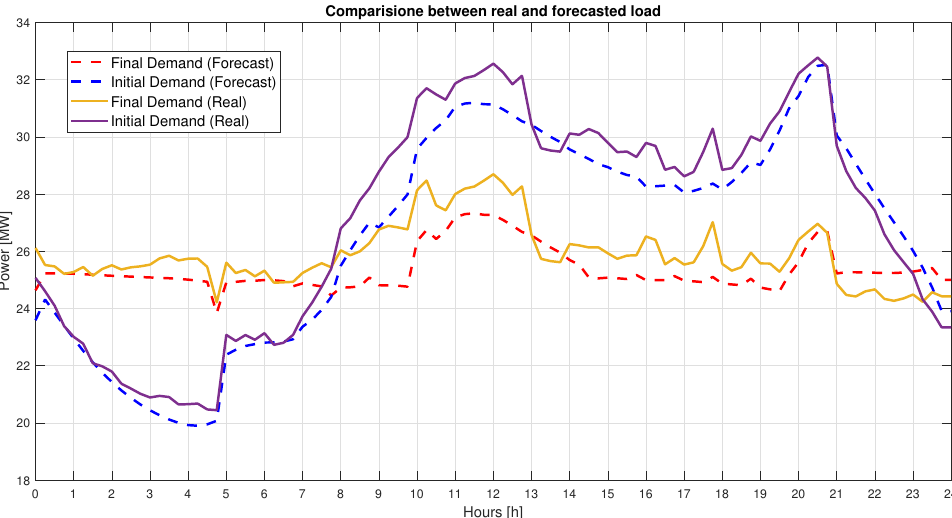
Figure 19. Comparison between forecasted and real demand.